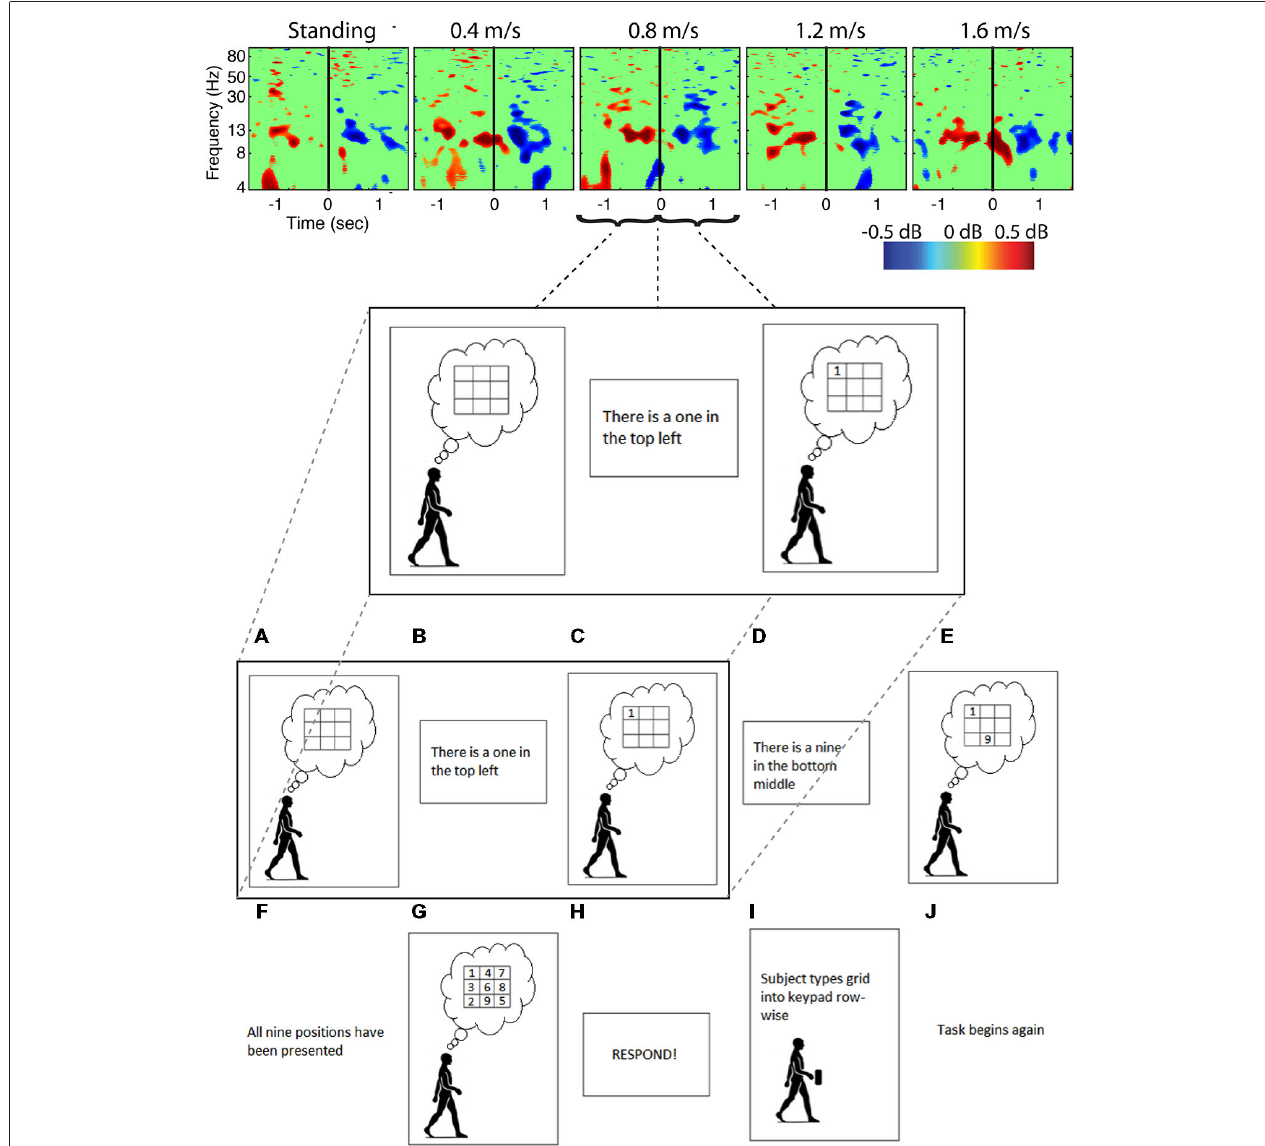
FIGURE 6 | Cognitive event related spectral perturbations. Spectral perturbations for subjects performing a Brooks spatial memory task show much smaller fluctuations within a smaller frequency band than the artifact data. Data was epoched around the stimulus (number) presentation, with solid vertical lines indicating the time the stimulus was